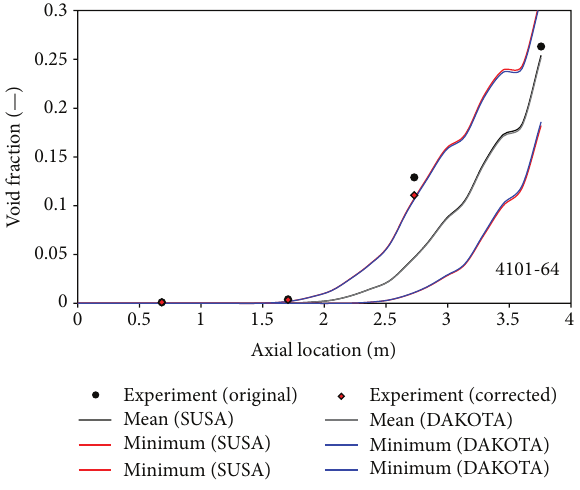
Figure 7: Axial void fraction profile for case